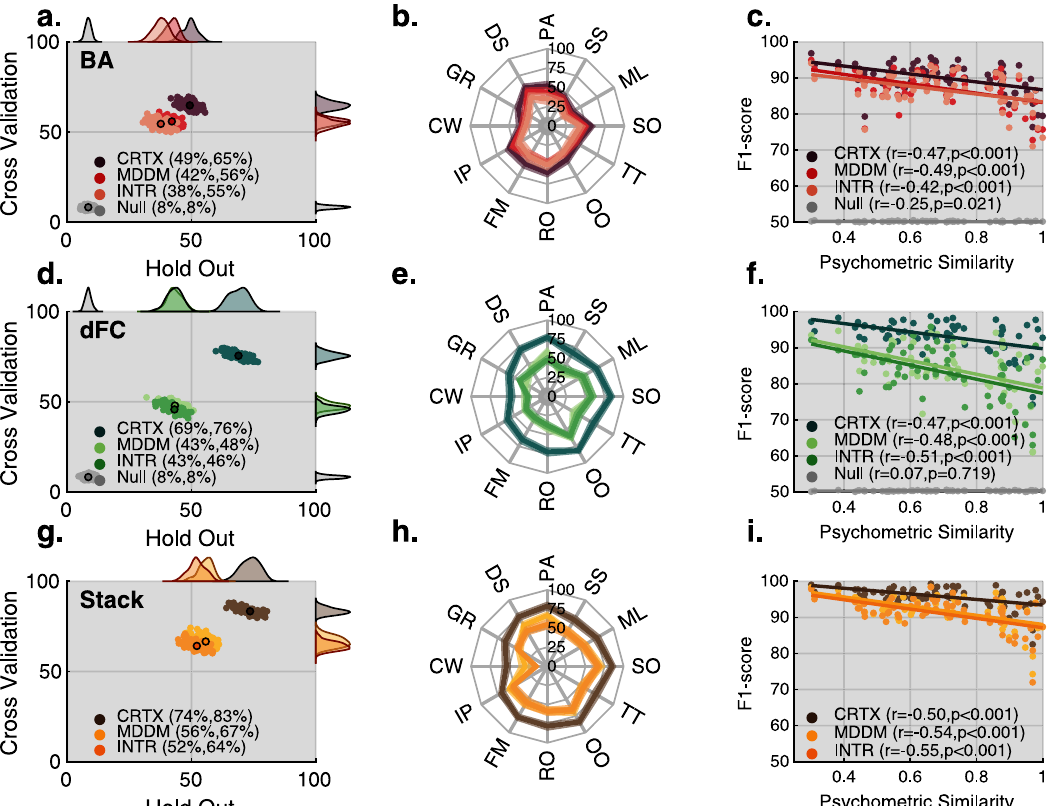
Fig. 4 Classi fi cation analysis across metrics and brain sets. The 12 tasks can be decoded based on either activation, connectivity or both metrics combined (Stack). The mean pairwise binary classi fi cation scores indicate a strong negative correlation with the psychometric similarity implying that behaviourally similar tasks are harder to distinguish. c , f , i The following scatter plots test association between psychometric similarities and different sources of classi fi cation accuracies using a left-tailed Pearson correlation coef fi cient test. All tests are FDR corrected within the comparison. c Exact p values: p CRTX = 0.0001, p MDDM = 0.0001, p INTR = 0.0003, p Null = 0.0204. f Exact p values: p CRTX = 0.0000 , p MDDM = 0.0000, p INTR = 0.0000, p Null = 0.7181. i Exact p values: p CRTX = 0.1e − 04 , p MDDM = 0.02e − 04, p INTR = 0.019e − 04. a , d , g Scatter plot of 12-way classi fi cation accuracy (F1-score) distributions across ROI sets (i.e. CRTX, MDDM and INTR). Y -axis values were estimated using within sample cross-validation and X -axis represents performance over subject independent held-out test set. a Voxel-wise BOLD activation (BA), d dynamic functional connectivity (dFC), and g stack models that combine information from both BA and dFC. Scatter plots show that: (1) models based on CRTX data outperform other ROI sets; (2) cross-validation performance estimation show that the models are slightly over fi tted; (3) combining connectivity and activity in a stack framework is evidence that these measures are complementary for classi fi cation. b , e , h Radar plot showing the per task f1-micro accuracy distributions of the held-out test-set. Classi fi cation accuracy was highly variable across tasks. In dFC, but not in BA, the overall CRTX f1-micro pattern was visually different from the other ROI sets. c , f , i Strong negative correlations were evident between the psychometric similarity measure ( x -axis) and binary classi fi cation accuracy ( y -axis); therefore, pairs of tasks that were behaviourally similar also evoked similar network states in the brain, which resulted in lower classi fi cation accuracy. Source data are provided as a Source Data fi